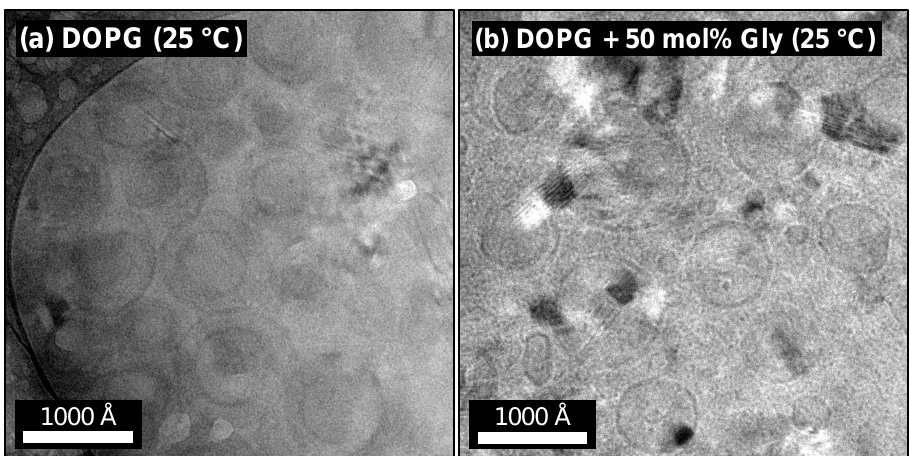
Figure 2. Cryo-TEM images of ( a ) DOPG and ( b ) DOPG with 50mol% glycyrrhizin in D 2 O as solvent. The samples were kept at room temperature ( ≈ 25 ◦ C) before freezing. In both cases, the typical pattern of unilamellar vesicles is